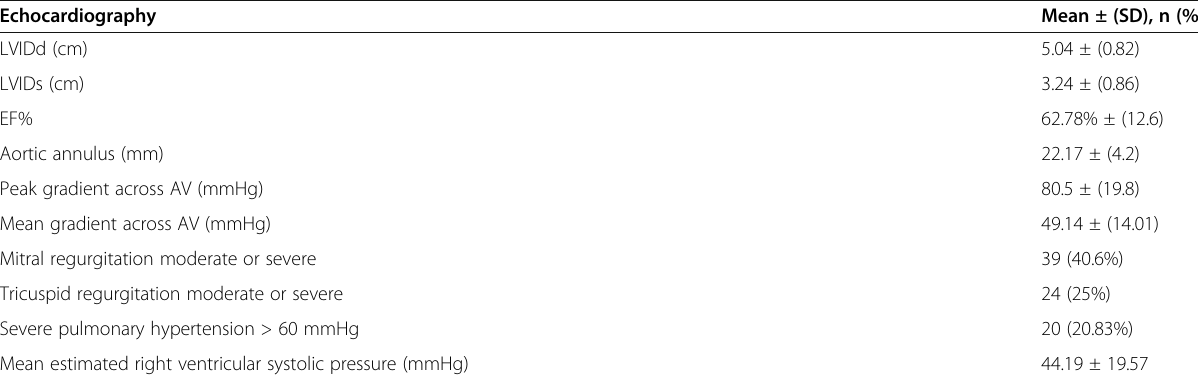
Table 2 Baseline